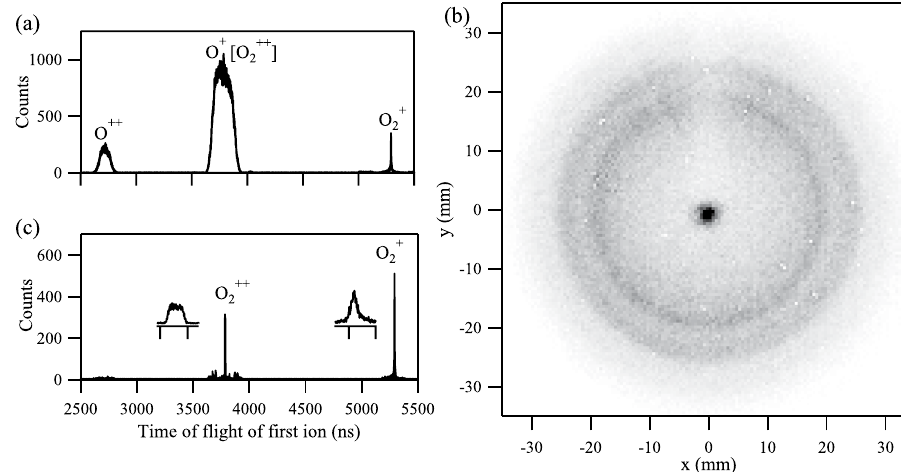
Figure 2. The ion time-of-flight spectrum ( a ) contains a sharp peak corresponding to the parent molecular ion, and two broad peaks corresponding to fragment atomic ions. In the ion image ( b ), the parent molecular ions arrive at the center, while the fragment atomic ions form concentric rings. The shadow observed in the upper- half is due to the gas needle. The selected time-of-flight spectrum corresponding only to ions arriving at center of the detector is shown in panel (c). Expanded views of parent ions are shown in the inserted plot in panel (c).